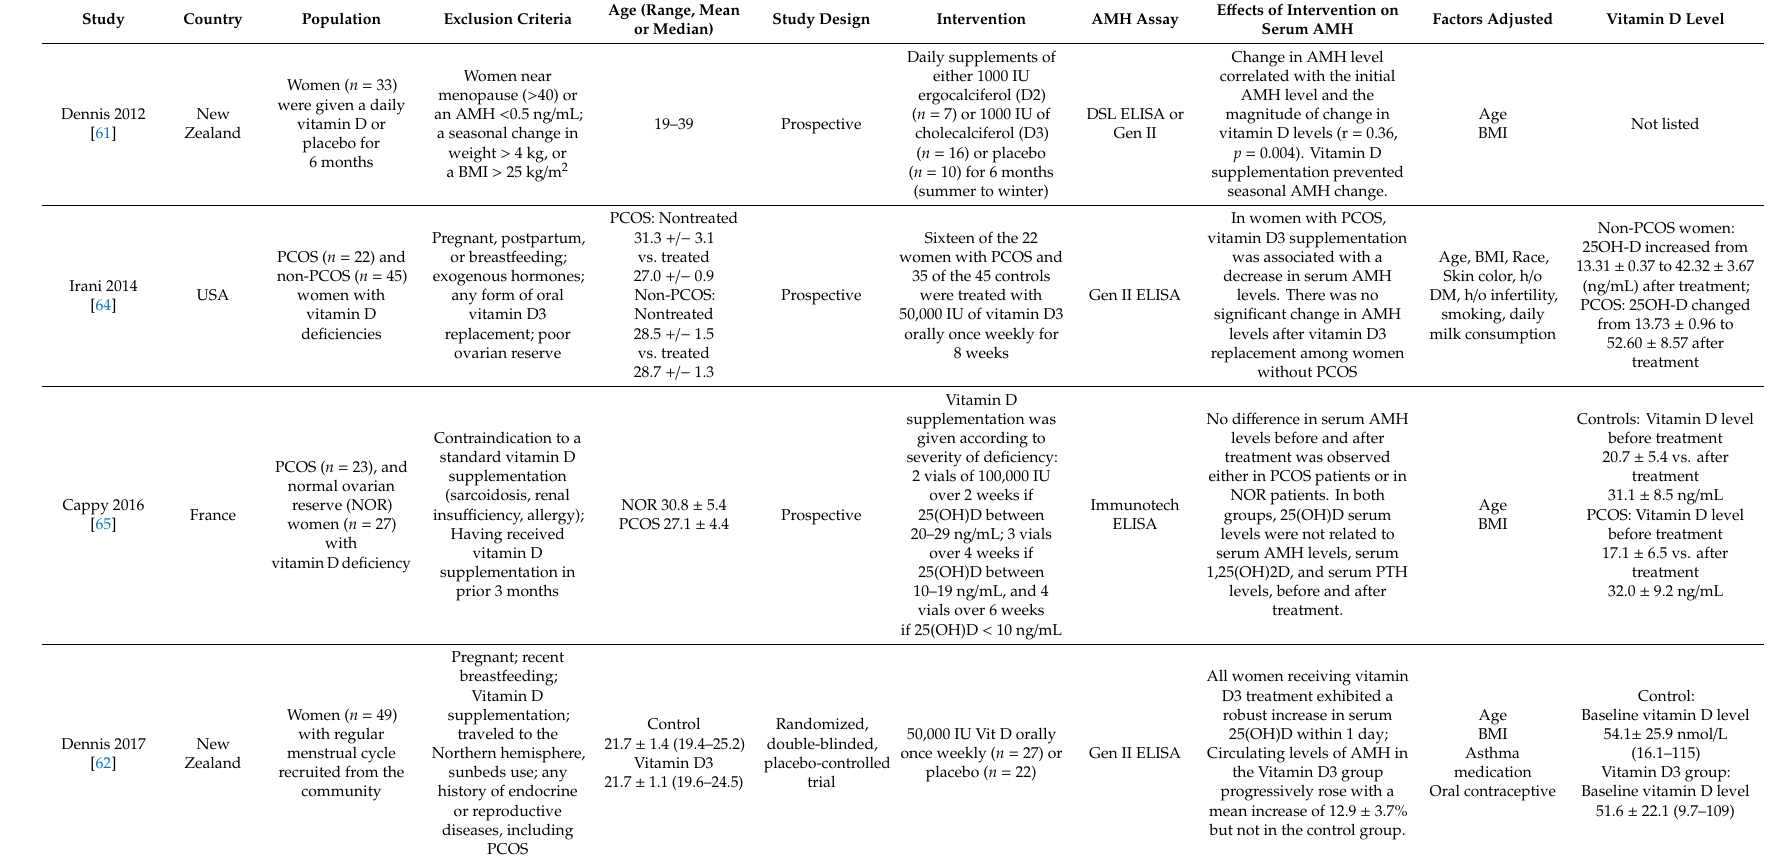
Table 2. Interventional